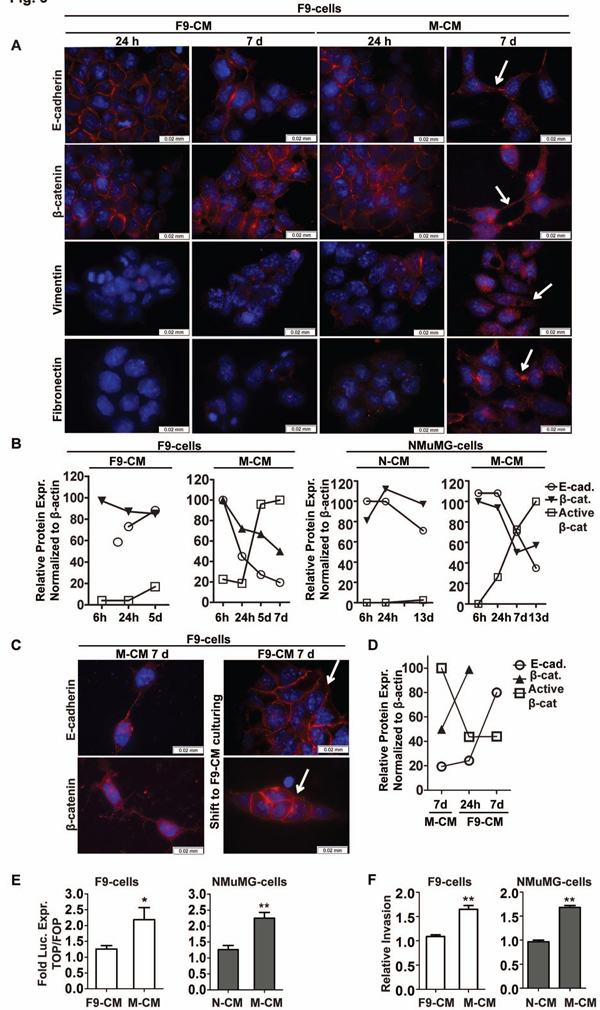
M2 polarized macrophages induce trans-differentiation, activation of the β-catenin pathway and invasion of F9- and NMuMG cells in vitro. (A) Immunofluorescence of E-cadherin, β-catenin, vimentin and fibronectin expression and cellular localization in F9-cells cultured in F9-CM or M-CM for 24 h or 7d. Pictures of NMuMG-cells are shown in Additional file 2: Figure S1. Scale bar = 0.02 mm. Proteins are colored red and nuclei were stained with DAPI (blue). Arrows indicate the location of the annotated protein in cells cultured in M-CM for 7d. (B) Relative protein expression normalized to β-actin levels (quantified from western blots shown in Additional file 2: Figure S2.) of E-cadherin, total and active β-catenin in F9-cells (left panels) and NMuMG-cells (right panels) cultured in F9-CM, N-CM or M-CM for 6 h, 24 h, 5d, 7d, and 13d. (C) Immunofluorescence of E-cadherin and β-catenin expression and cellular localization in F9-cells cultured in M-CM for 7d (left panel), followed by additional culture in F9-CM for 7d (right panel). Scale bar = 0.02 mm. Proteins are colored red and nuclei were stained with DAPI (blue). Arrows indicate the location of the annotated protein in cells after 7d culture in F9-CM. (D) Relative protein expression normalized to β-actin levels (quantified from western blot shown in Additional file 2: Figure S2A) of E-cadherin, total and active β-catenin in F9-cells cultured in M-CM for 7d, followed by F9-CM for additional 24 h and 7d. (E) Fold luciferase expression (TOPFLASH/FOPFLASH) in F9-cells (left) and NMuMG-cells (right) after 7d or 13d of culture, respectively, in F9-CM, N-CM or M-CM; n = 7; bar = means ± SEM; *P < 0.05. **P < 0.005, unpaired t-test. (F) Invasion by F9-cells (n = 8) and NMuMG-cells (n = 3) in response to F9-CM, N-CM or M-CM (48 h, 1% Matrigel) calculated relative to F9-CM or N-CM, respectively. **P < 0.005, unpaired t-test; bars = means ± SEM.